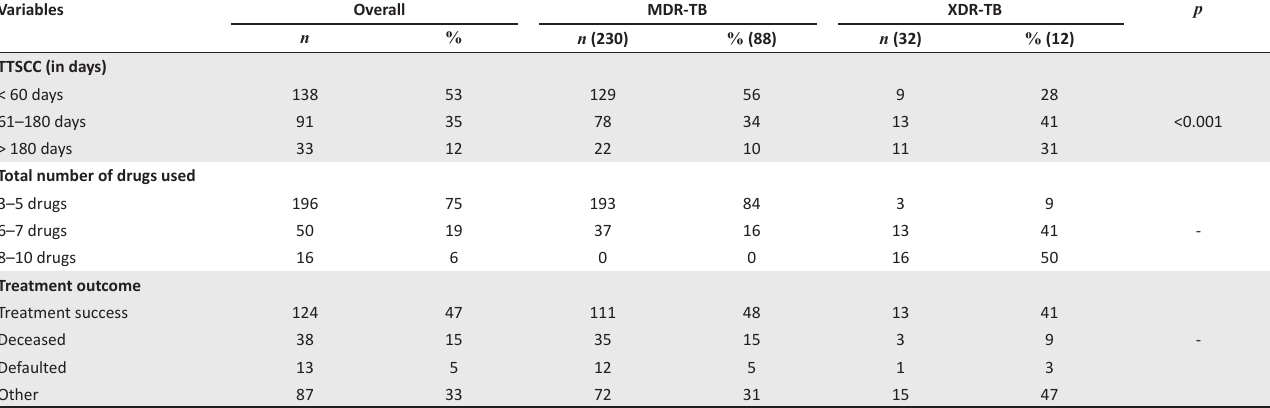
FIGURE 2: Time to sputum culture conversion for multi-drug-resistant tuberculosis and extensively drug-resistant tuberculosis TABLE 4: Drug-resistant tuberculosis, time to sputum culture conversion, total number of drugs and treatment outcome for patients who achieved sputum culture conversion.